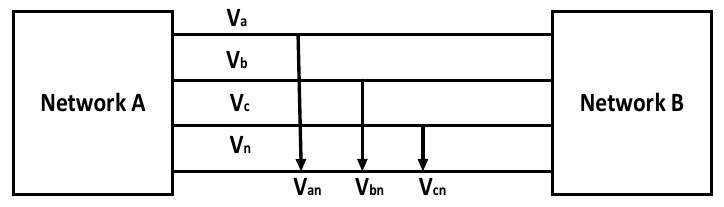
Figure 5. Two network system.